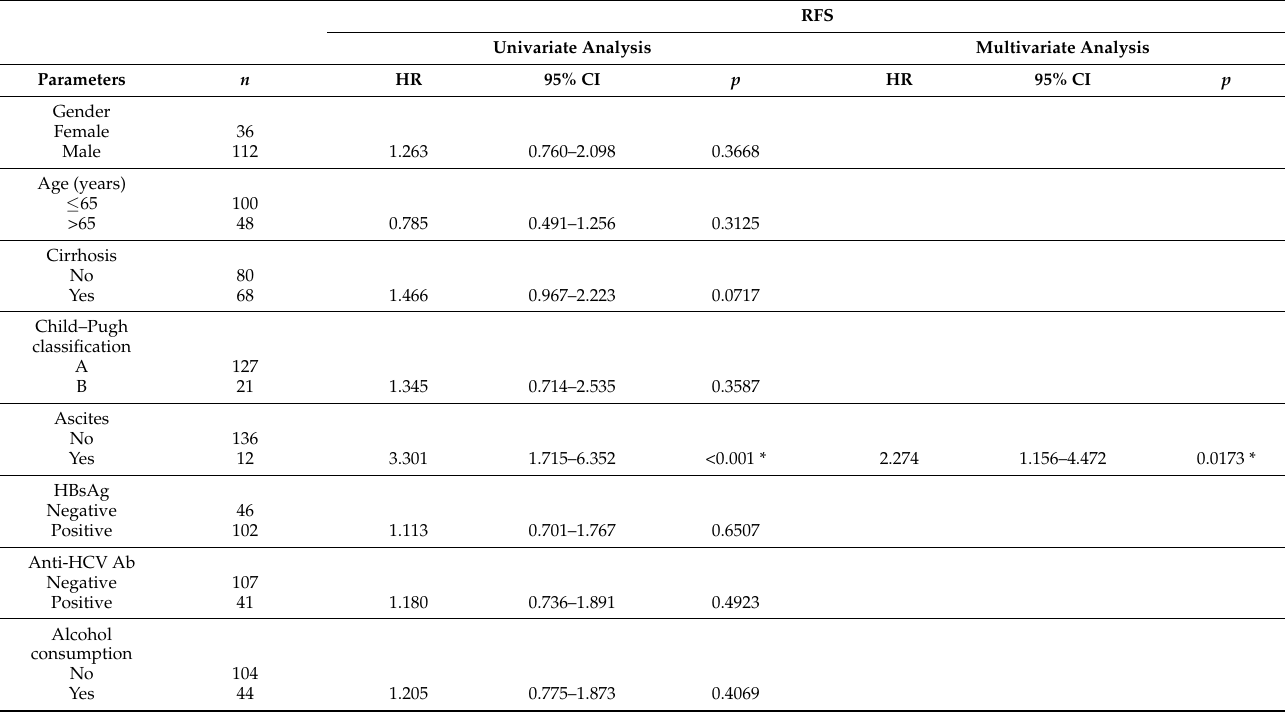
Table 3. Analysis of factors that influenced RFS of all patients (cohort